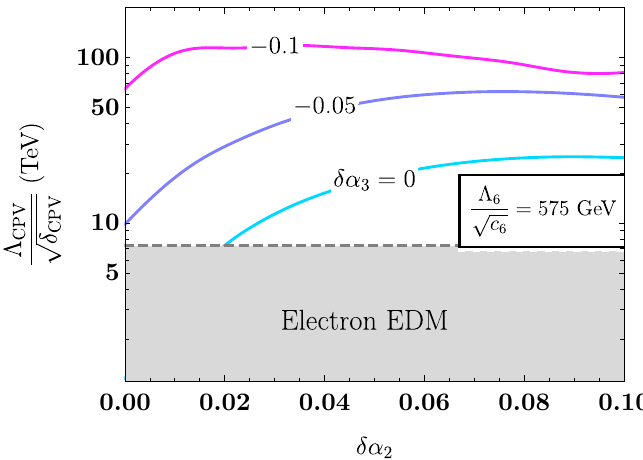
Figure 2 . Shown here are contours where the correct baryon asymmetry is obtained as a function p of (cid:14)(cid:11) 2 and the scale of new CP violation (cid:3) CPV = (cid:14) CPV , for di(cid:11)erent choices of (cid:14)(cid:11) 3 and a (cid:12)xed p choice of (cid:3) 6 = c 6 = 575 GeV. In light blue is where (cid:11) 3 is kept at its SM value, while the purple and pink contours are shown for (cid:14)(cid:11) 3 = (cid:0) 0 : 05 ; (cid:0) 0 : 1 respectively. The non-observation of an